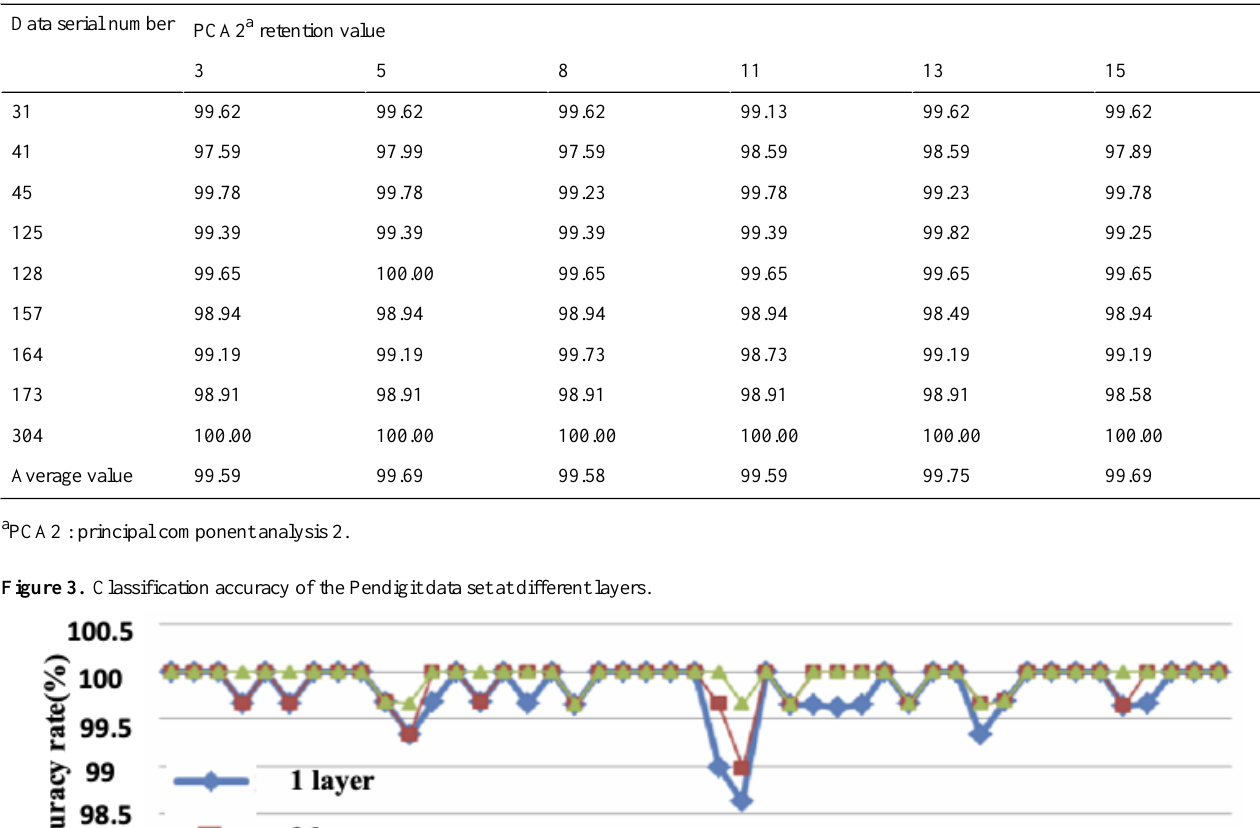
Table 2. Classification accuracy of Letter data under different PCA2 retention values (%).